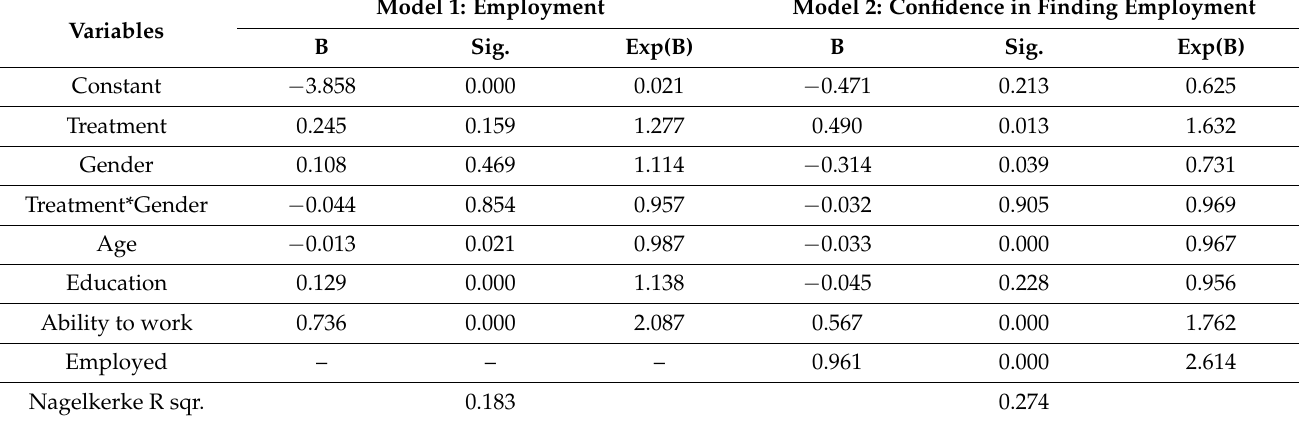
Table 1. Binary logistic regressions on gendered employment impacts and confidence in finding employment in the following 12